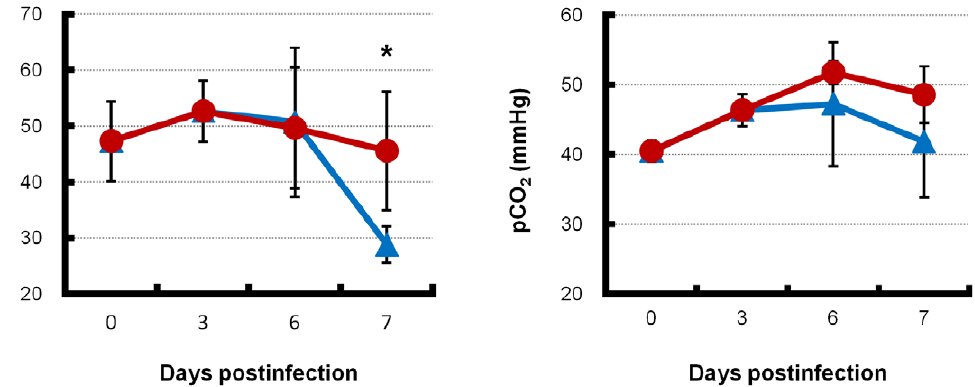
Figure 7. Blood O 2 and CO 2 pressures of infected mice with combination therapy or monotherapy. Mice intranasally inoculated with an extremely high dose (3741 MLD 50 ) of PR8 virus were treated with laninamivir octanoate. The mice were additionally administered artificial surfactant (combination therapy, red lines) or normal saline solution (monotherapy, blue lines) intranasally once daily during 3–14 days postinfection. Mice ( n =3–6) in each group were sacrificed at the indicated days postinfection. Mice in each group were sacrificed at 7 days postinfection, when the mouse survival rate in the monotherapy group was approximately 50%. Blood was collected and immediately measured for O 2 (left panel) and CO 2 (right panel) pressures using the i-STAT portable blood gas analyzer. Differences in means 6 SD and p values are shown. * p , 0.05.